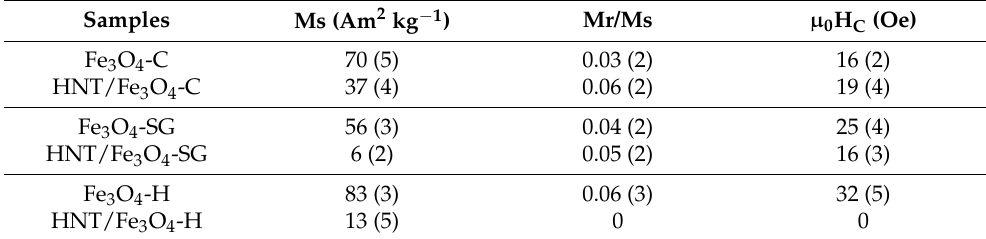
Table 3. Saturation magnetization M S , reduce remanence magnetization (Mr/M S ) and co- ercive field ( µ 0 H C ) of Fe 3 O 4 -C, Fe 3 O 4 -SG, Fe 3 O 4 -H, HNT/Fe 3 O 4 -C, HNT/Fe 3 O 4 -SG, and HNT/Fe 3 O 4 -H samples.